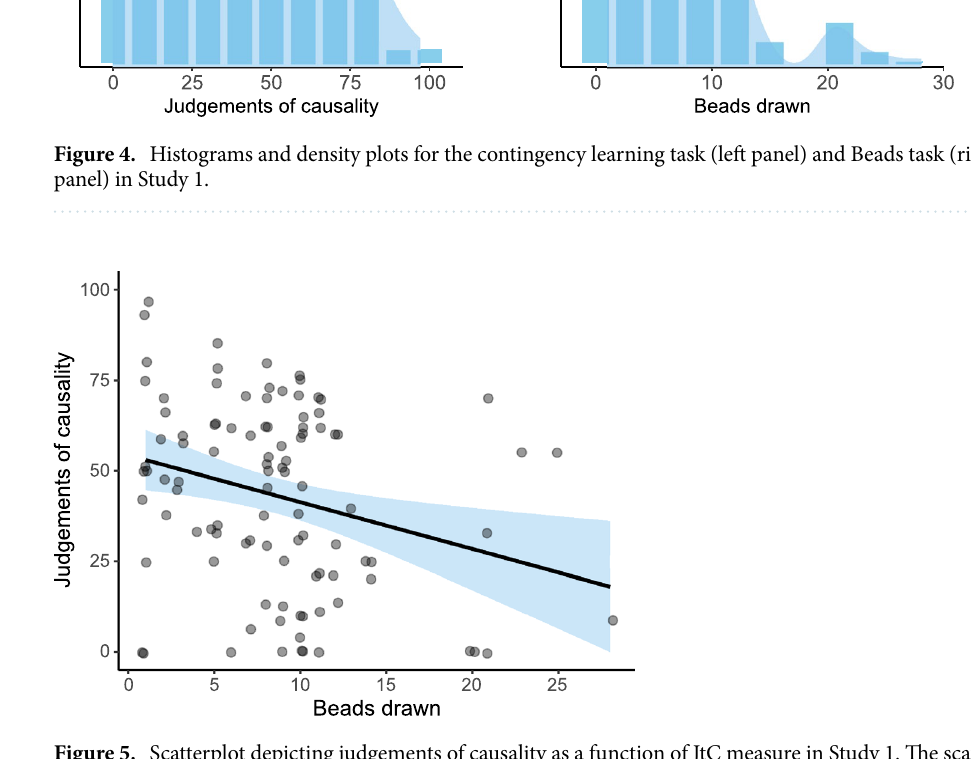
Figure 5. Scatterplot depicting judgements of causality as a function of JtC measure in Study 1. The scatterplot shows causal judgements (vertical axis), and the number of beads drawn in the Beads task (horizontal axis), which assesses the JtC bias. The line fitting the data points displays a negative slope, indicating that those participants who required more information in the Beads task were also more accurate in their causal estimations. We added horizontal jitter to the data points to prevent